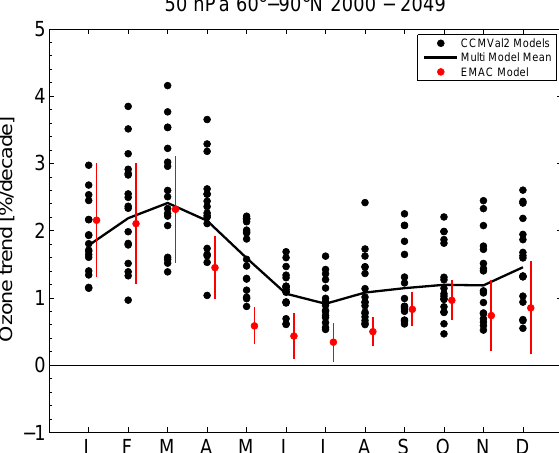
Fig. 4. Arctic ozone trends at 50hPa between 1979 and 2005 from CCMVal2 models (black dots), EMAC model (red dots with error bars) and observed ozone trends from Randel and Wu (2007) (red line with diamonds).